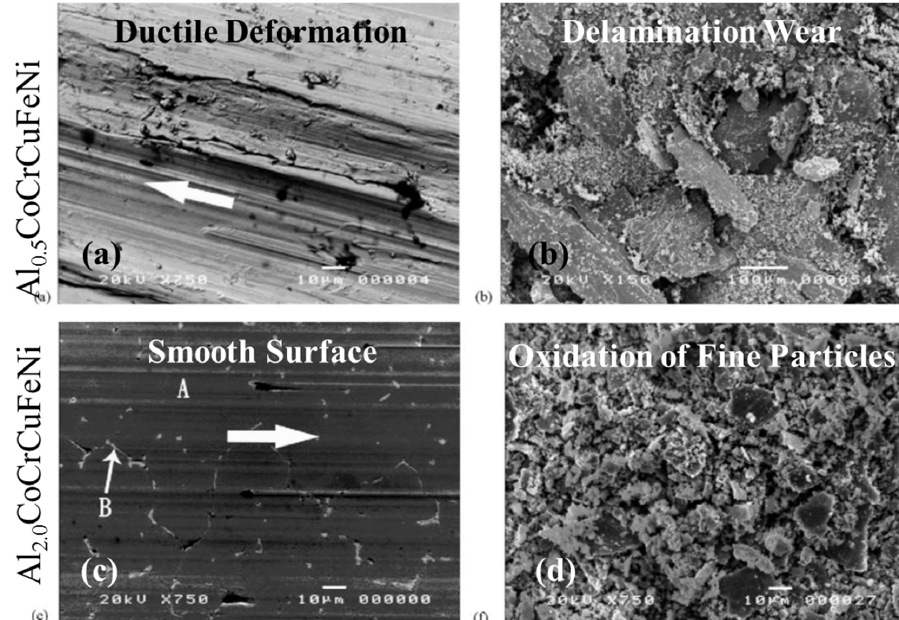
Figure 25. Deformation and wear mechanisms for Al 0.5 CoCrCuFeNi alloys: ( a ) Ductile deformation showing long grooves with minimal lateral cracks ( b ) wear particles showing large flakes indicating delamination ( c ) smooth surface characteristic of bcc and high hardness alloys, ( d ) smaller wear particles showing significantly higher oxidation seen from lighter shades from oxide charging [89] (reprinted with permission from Elsevier).